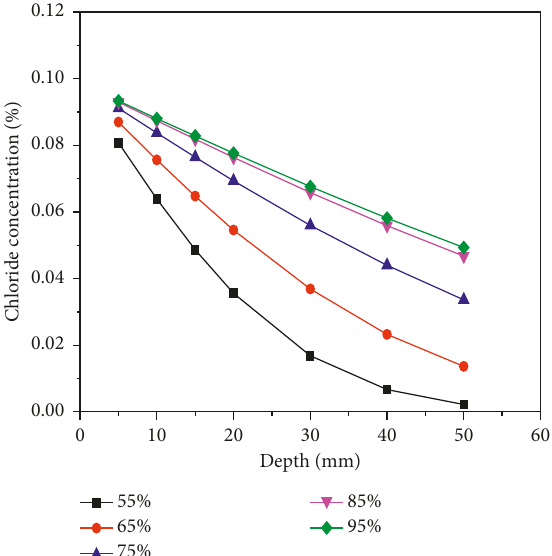
Figure 9: Chloride profile vs. ambient humidity according to the proposed model (equations (14a) and